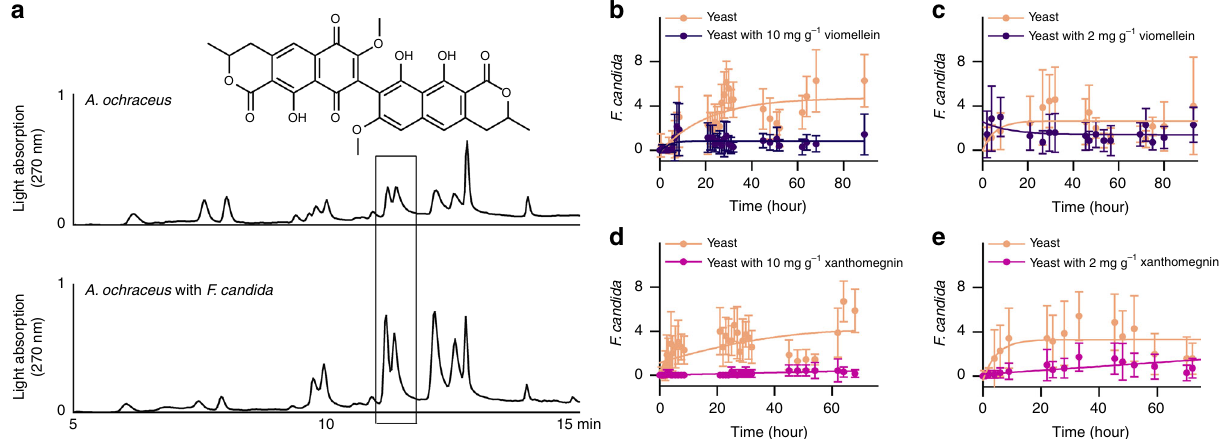
Fig. 8 Antifeedant activity of viomellein and xanthomegnin. a Aspergillus ochraceus was grown on rice kernels for 5 d. The springtail Folsomia candida was added to fungal cultures and allowed to feed for 6 d. The cultures were extracted with chloroform/methanol (80:20) and analysed via HPLC with light absorption detection. Viomellein appeared as two peaks originating from stereoisomers (atropisomers) and separated owing to restricted intramolecular rotation around the biaryl axis. b – e The food preference of springtails Folsomia candida for yeast amended with viomellein or xanthomegnin. The animals were placed into the middle of arenas containing dry yeast on one side and dry yeast amended with viomellein or xanthomegnin on the other side. The number of springtails visiting each diet was recorded in a time series. Seven replicates were used, each with 20 animals. No statistical test was used for the data obtained for 10 mg g − 1 of bis-naphthopyrones b , d . For the data obtained with 2 mg g − 1 of bis-naphthopyrones c , e , cumulative values for all time points beginning with 20 h were compared using two-tailed t tests. The preference for yeast without naphthopyrones was highly signi fi cant for